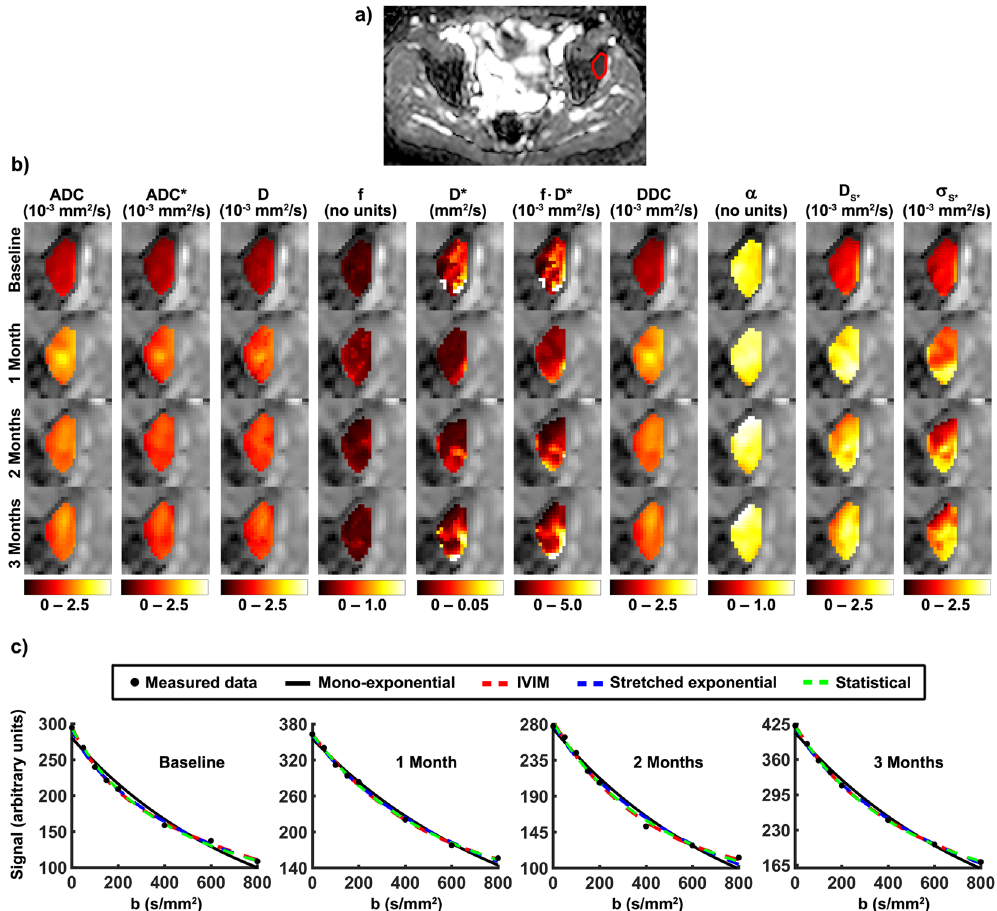
Figure 2. Parameter maps for an exemplary patient with a pelvic bone metastasis from prostate cancer: ( a ) ROI circumscribing the lesion superimposed onto the pre-treatment ADC map, ( b ) enlarged sections showing the parameter maps of the various diffusion parameters before therapy and one, two, and three months after treatment onset, and ( c ) measured signals and fitted curves of one voxel within the lesion at each time point.